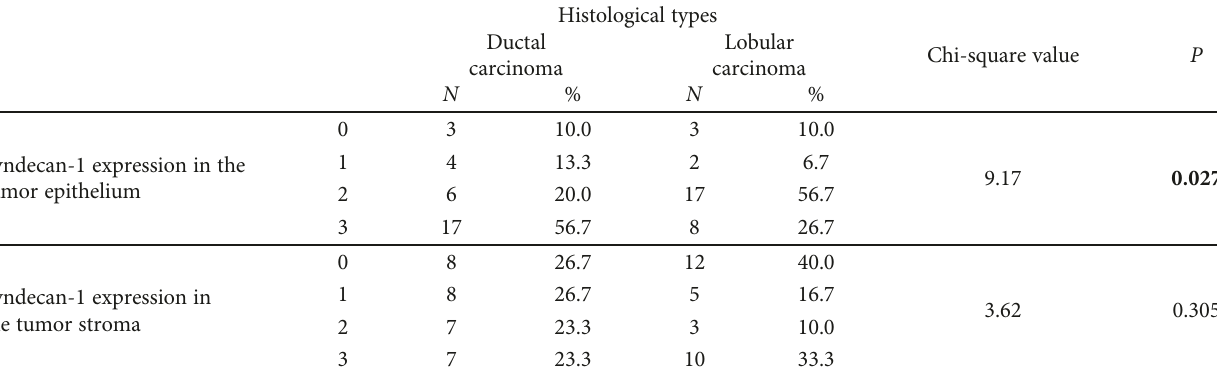
Table 2: The distribution of the intensity of the Sdc1 expression by the levels in the tumor epithelium and the stroma of primary IDC and ILC.